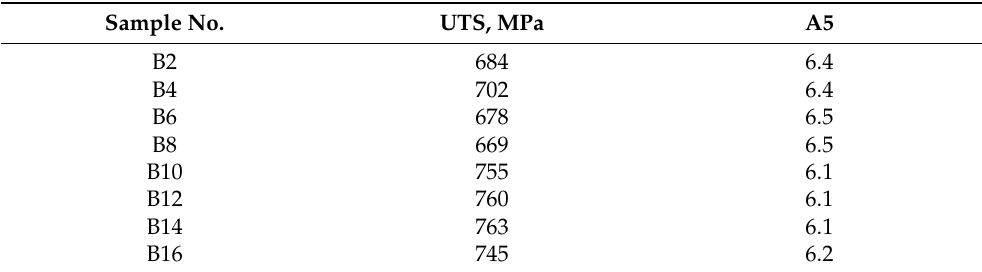
Table 8. Tensile strength test (UTS) results of welded joints made of DOCOL 1200 M and DOCOL 1300 M steel.